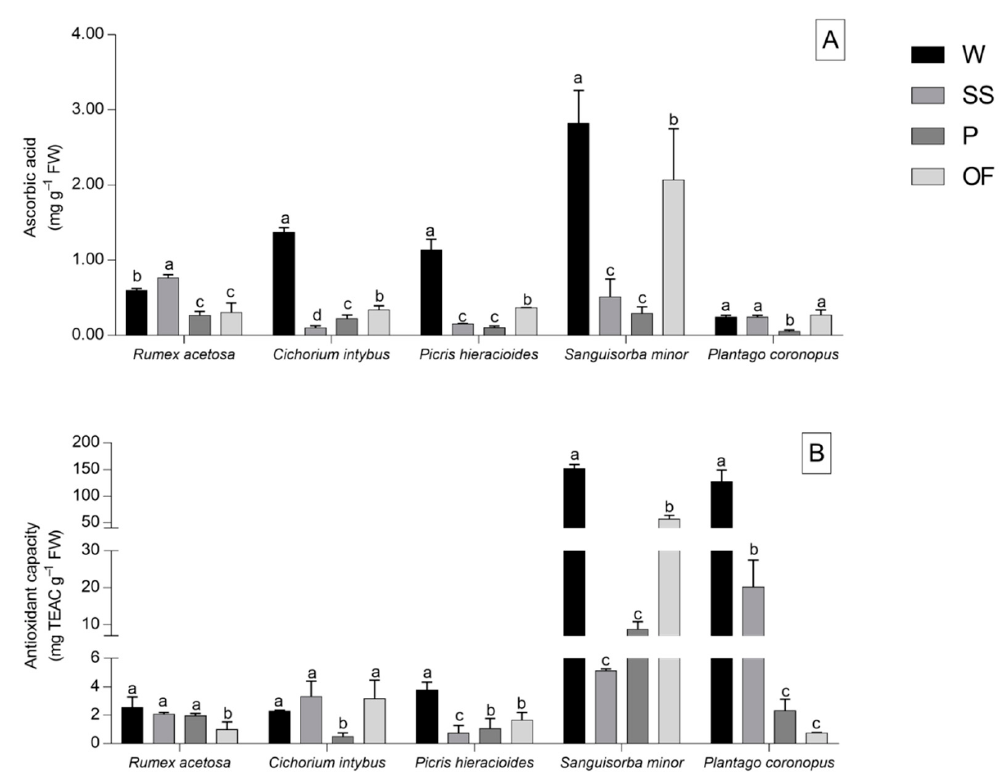
Figure 4. Total ascorbic acid content ( A ) and antioxidant capacity ( B ) of Rumex acetosa , Cichorium intybus , Picris hieracioides , Sanguisorba minor , and Plantago coronopus wild-collected (W) and domesticated according to three different methods: “soilless” (SS), pot (P), and open field (OF). Each value is the mean (± SD) of three replicates. Means keyed with a different letter are significantly different and means not keyed with letters are not significantly different for p = 0.05, considering each species independently and following one-way ANOVA, with wild-collection or the different domestications as the variability factor.